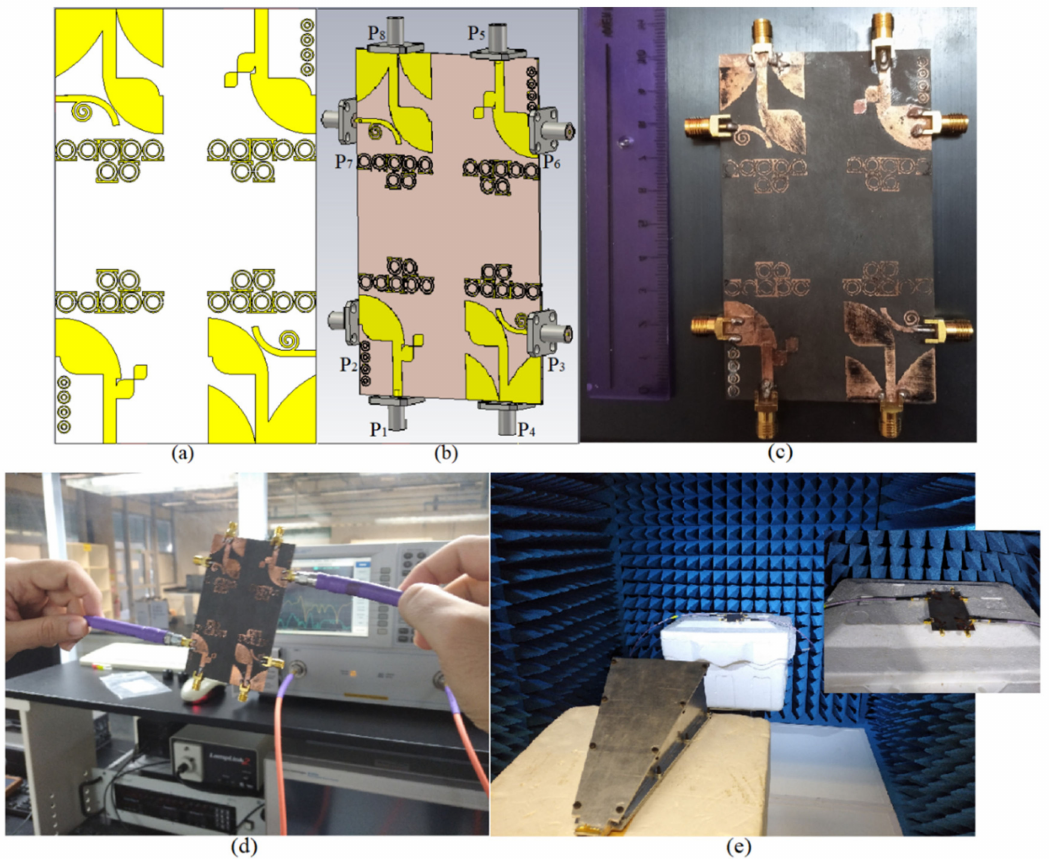
Figure 17. The MIMO antennas on a board with the same size as a smartphone: ( a ) 2D view of the prototype of the MIMO antenna, ( b ) 3D view of the structure with the SMA connectors, ( c ) fabricated MIMO for smartphone, ( d ) S-parameter measurement setup, and ( e ) radiation pattern measurement setup.